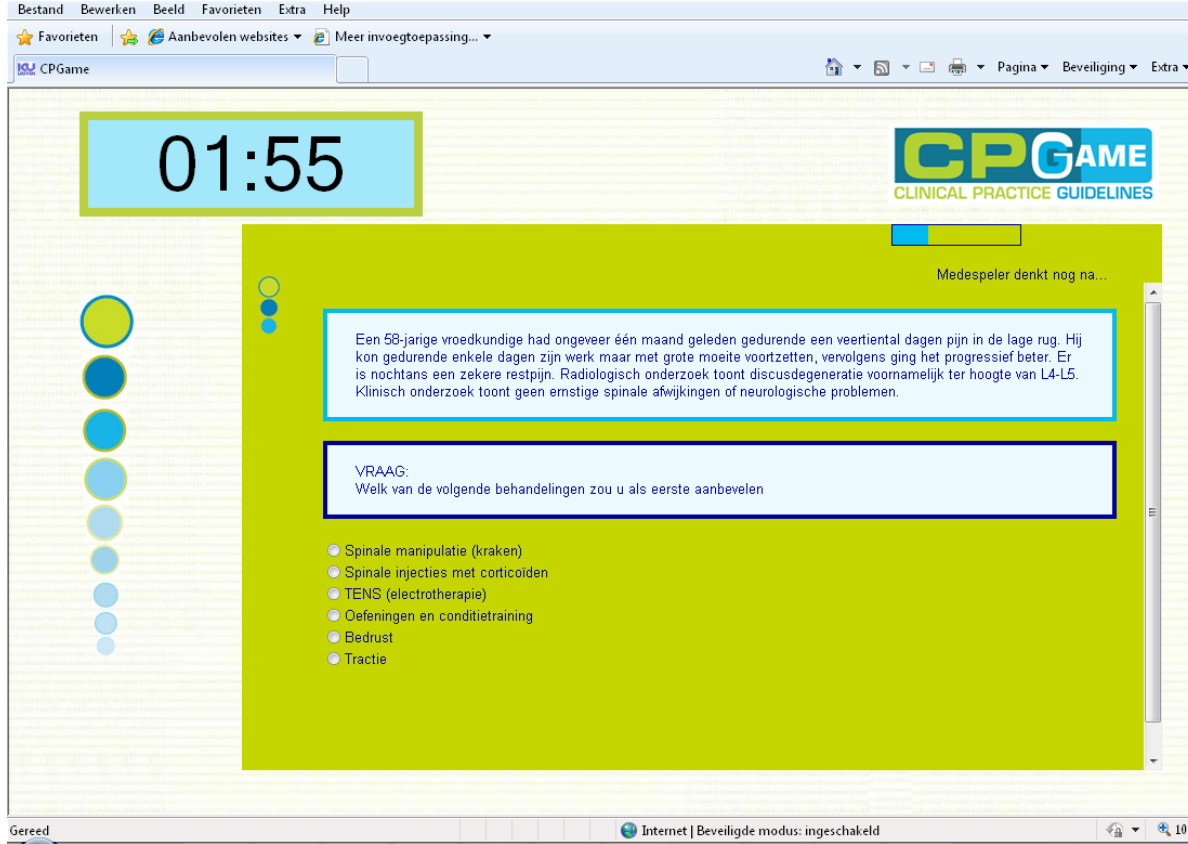
Figure 1. Screen capture of a multiple choice scenario in the CPGame application.